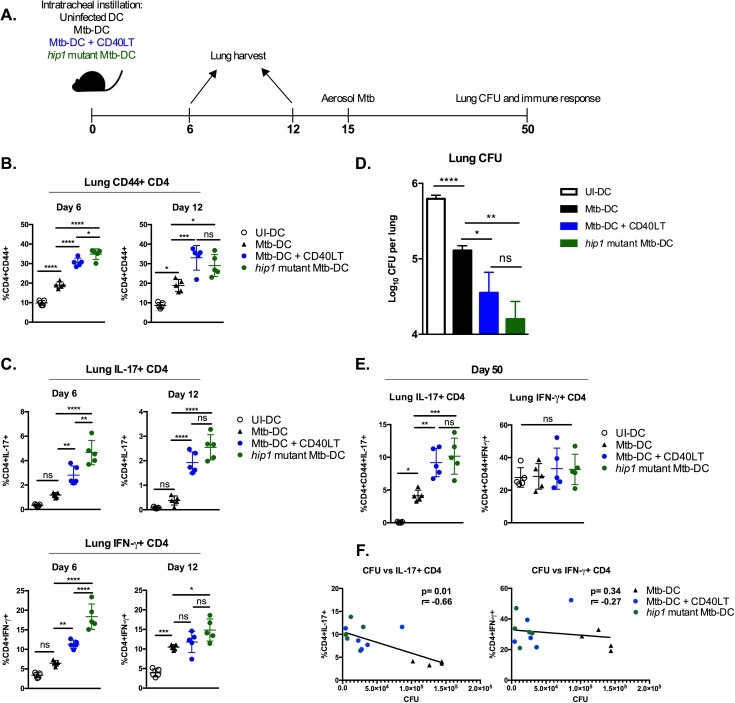
CD40 engagement of DCs enhances control of Mtb infection.B6 DCs were left uninfected or infected with heat-killed Mtb in the presence or absence of CD40LT treatment (1 μg/ml), or infected with heat-killed hip1 mutant Mtb, each for 24 hours. Cells were washed twice and reconstituted in PBS to deliver 1x106 DC per mouse intratracheally. (A) Diagram of experimental design. Lung responses were assessed 6 and 12 days post-instillation. Mice were infected through the aerosol route with ~100 CFU Mtb 15 days post-instillation and bacterial burden was assessed 35 days (5 weeks) post-challenge. (B) Frequencies of CD44+ CD4 T cells in the lungs 6 and 12 days after intratracheal instillation of DCs. (C) Frequencies of IL-17+ (top) and IFN-γ+ (bottom) CD4+ cells in the lungs 6 and 12 days after intratracheal instillation of DCs. Cells were stimulated with PMA (80 ng/ml) and ionomycin (500 ng/ml). (D) Lung bacterial burden 35 days post-challenge (overall day 50 post-DC intratracheal instillation). Bacterial burden was assessed by plating homogenized lungs on 7H10 agar plates and counting CFU. (E) Lung CD4+ IL-17+ and IFN-γ+ frequencies at day 50 following Mtb whole cell lysate (10 μg/ml) restimulation. (F) Correlation plots showing association between lung bacterial burden and IL-17 (left) or IFN-γ (right) responses to WCL restimulation. A linear regression was utilized to generate a best-fit line and Spearman’s correlation coefficient calculated. 4–5 mice were used for each group. Statistical significance (B-E) was determined using one-way analysis of variance correcting for multiple comparisons. * p<0.05, ** p<0.005, *** p<0.0005, **** p<0.0001, ns = not significant.